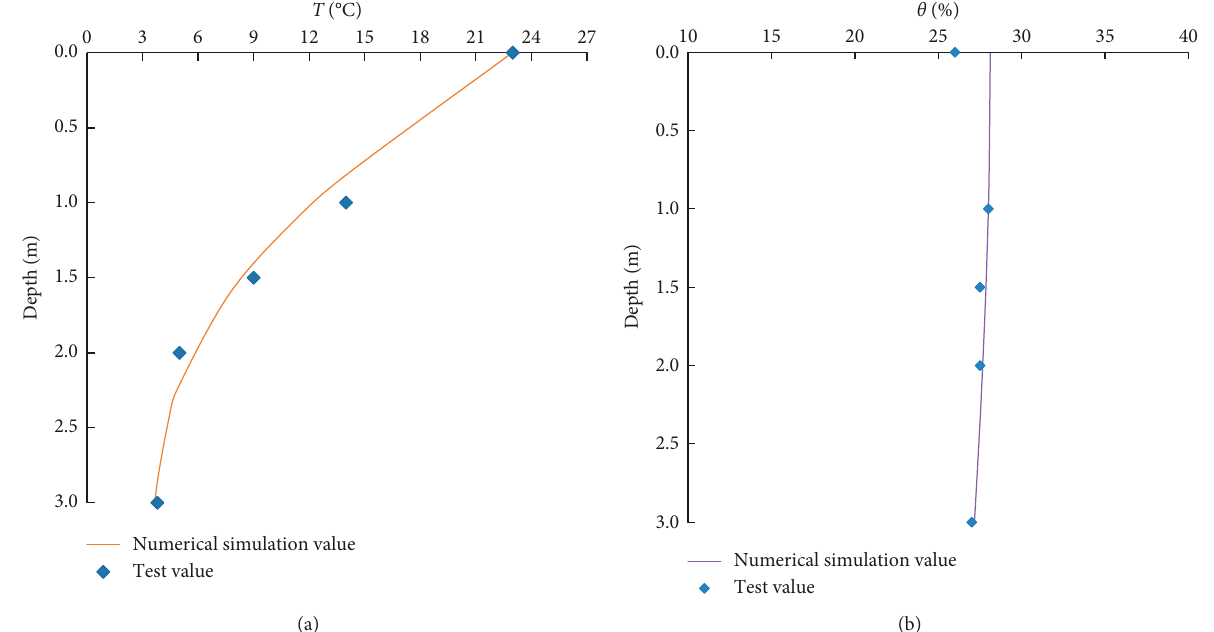
Figure 4: Comparison of calculated values with test values. (a) Temperature distribution with depth; (b) water content distribution with depth.